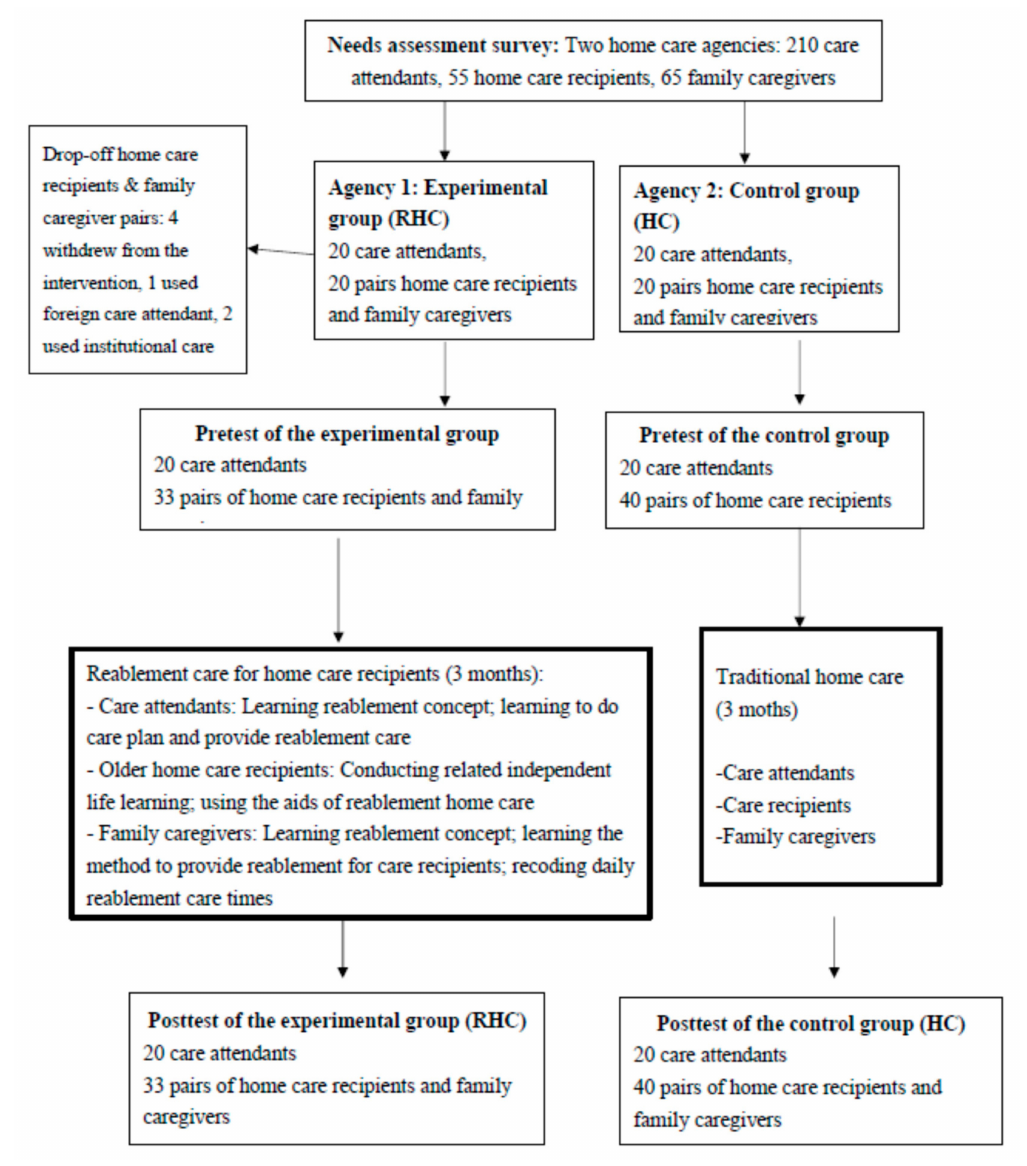
Figure 1. Flow chart of the intervention of the reablement home care